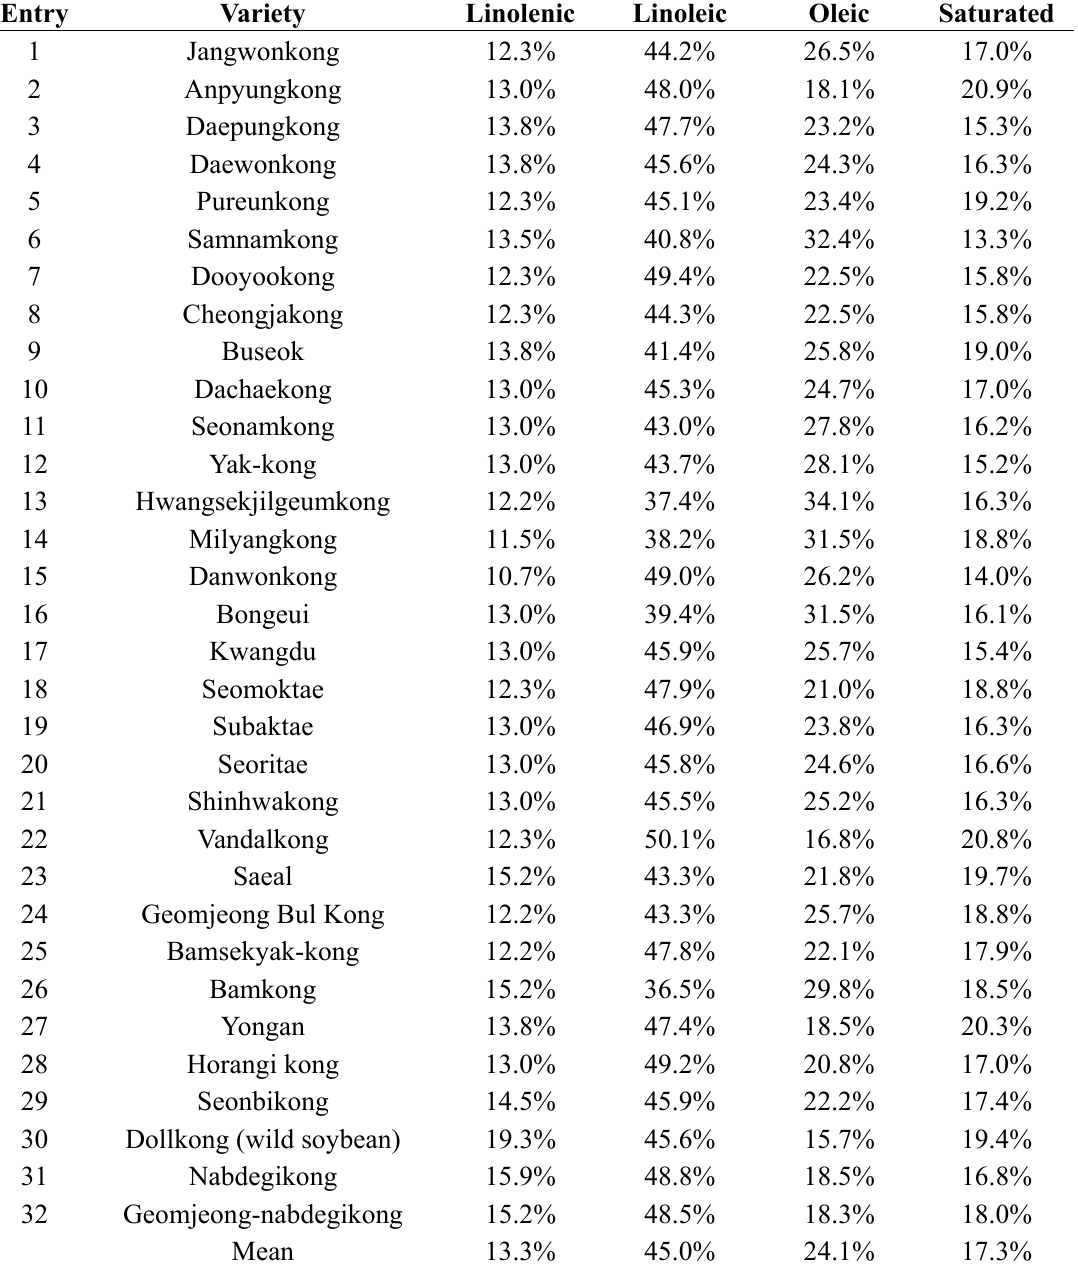
Table 3. TAG composition of soybean oils using 1 H-NMR